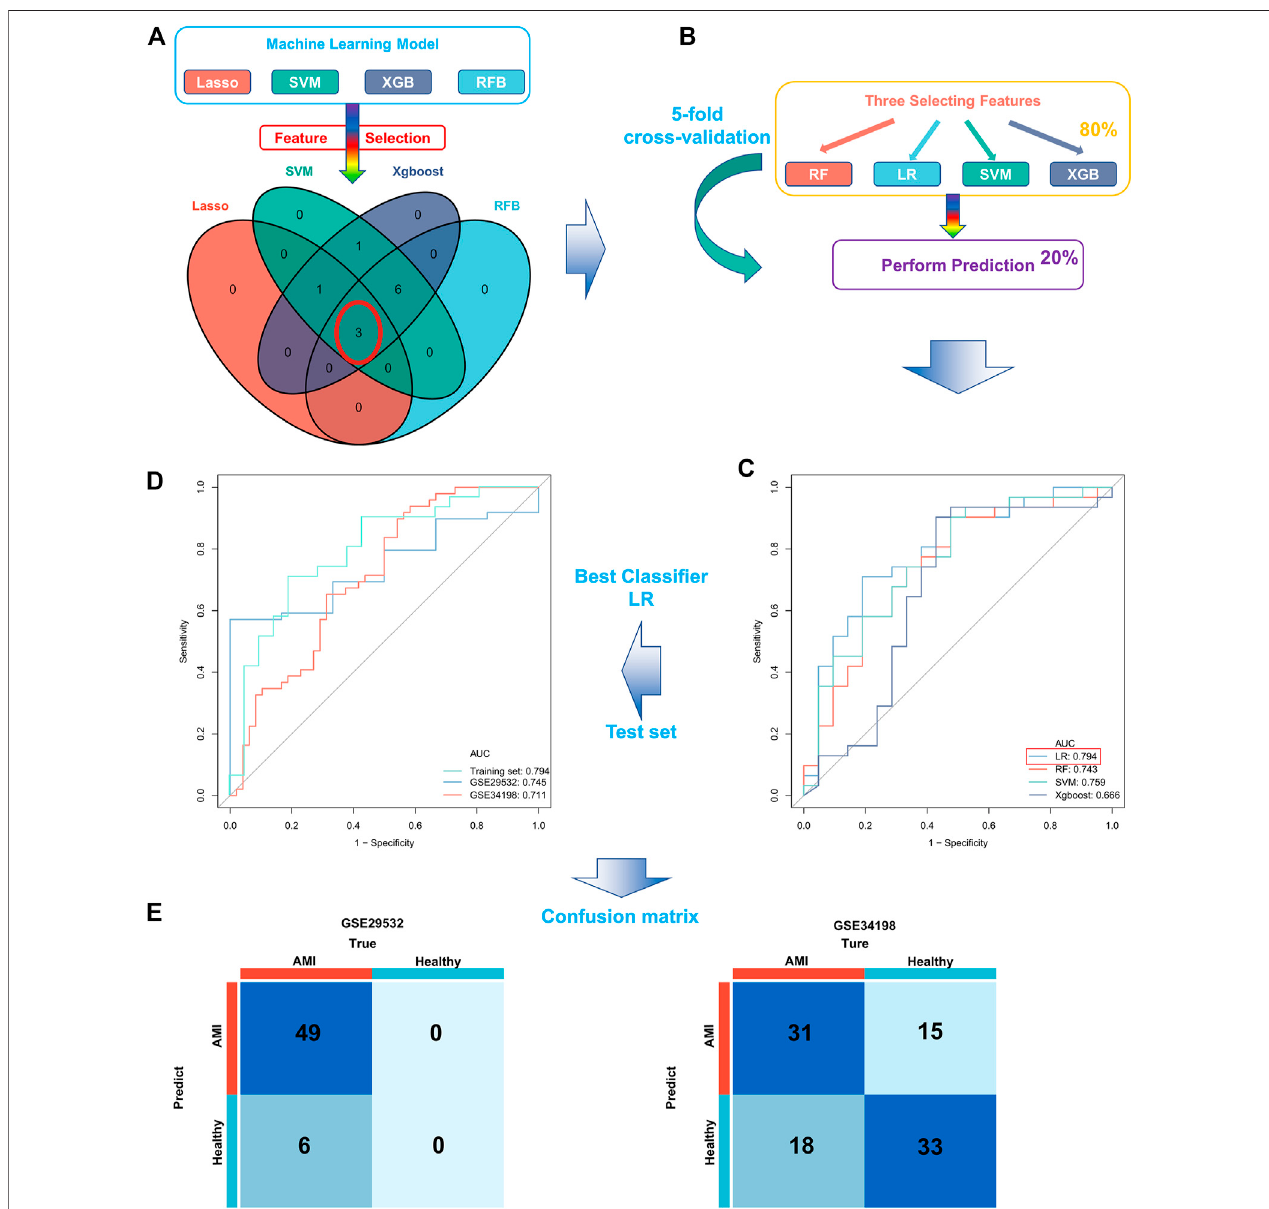
FIGURE 4 | Construction and validation of a ferroptosis-related AMI prediction model. (A) Screening of three key FRGs in the GSE48060 dataset using four machine learning algorithms; (B) Schematic diagram oftraining and validationofastable classi fi er inthe training cohortusing four machine learning algorithmsbased on fi ve-foldcross-validation; (C) ROCcurvesoffourpredictorsbasedoncross-validationinthetrainingcohort; (D) ROCcurvesforapplyingtheoptimalclassi fi er(LR)totwo external validation cohorts; (E) Confusion matrix of the predictors in two external validation cohorts. Left, GSE29532; right, GSE34198.